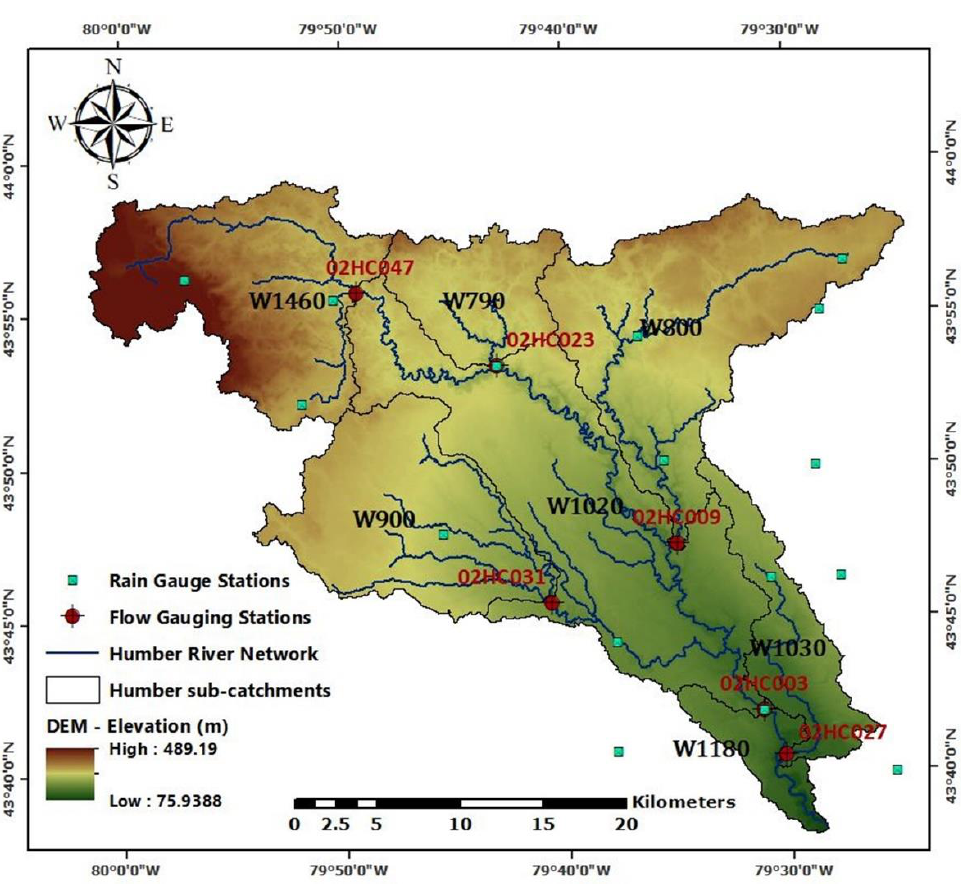
Figure 1. Location of Humber River Basin in Southern Ontario, with the rain and flow gauge stations.